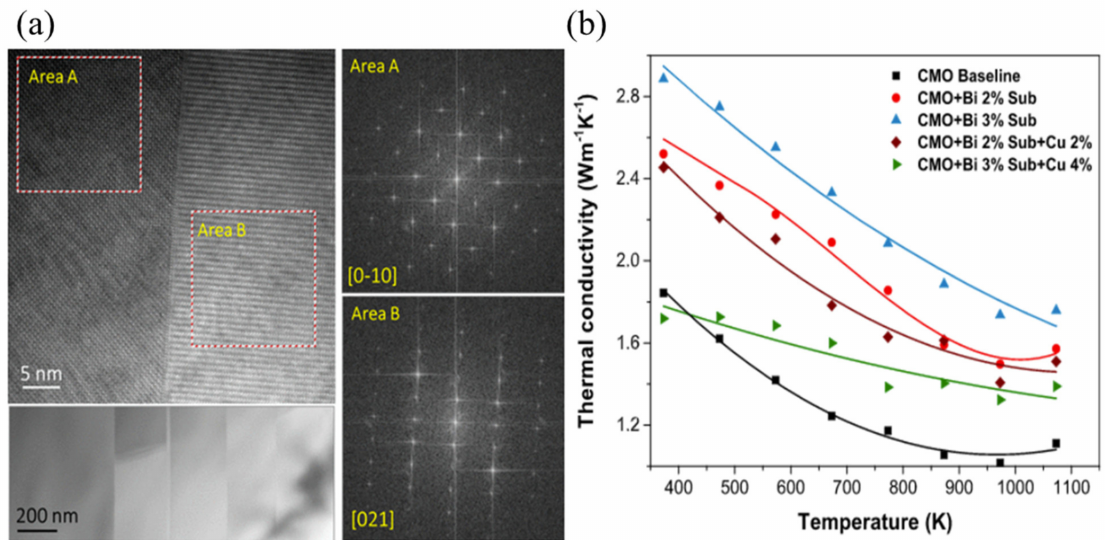
Figure 39. ( a ) HRTEM image taken from the Cu-added Bi-doped Ca MnO 3 − δ samples. Fourier transformation from the corresponding nanodomains with different orientation. ( b )Temperature dependence of thermal conductivity in Ca 1–x Bi x MnCu y O 3 − δ [270]. Reprinted from ACS Applied Materials & Interfaces, Grain Boundary Phase Segregation for Dramatic Improvement of the Thermoelectric Performance of Oxide Ceramics, Xueyan Song, Sergio A. Paredes